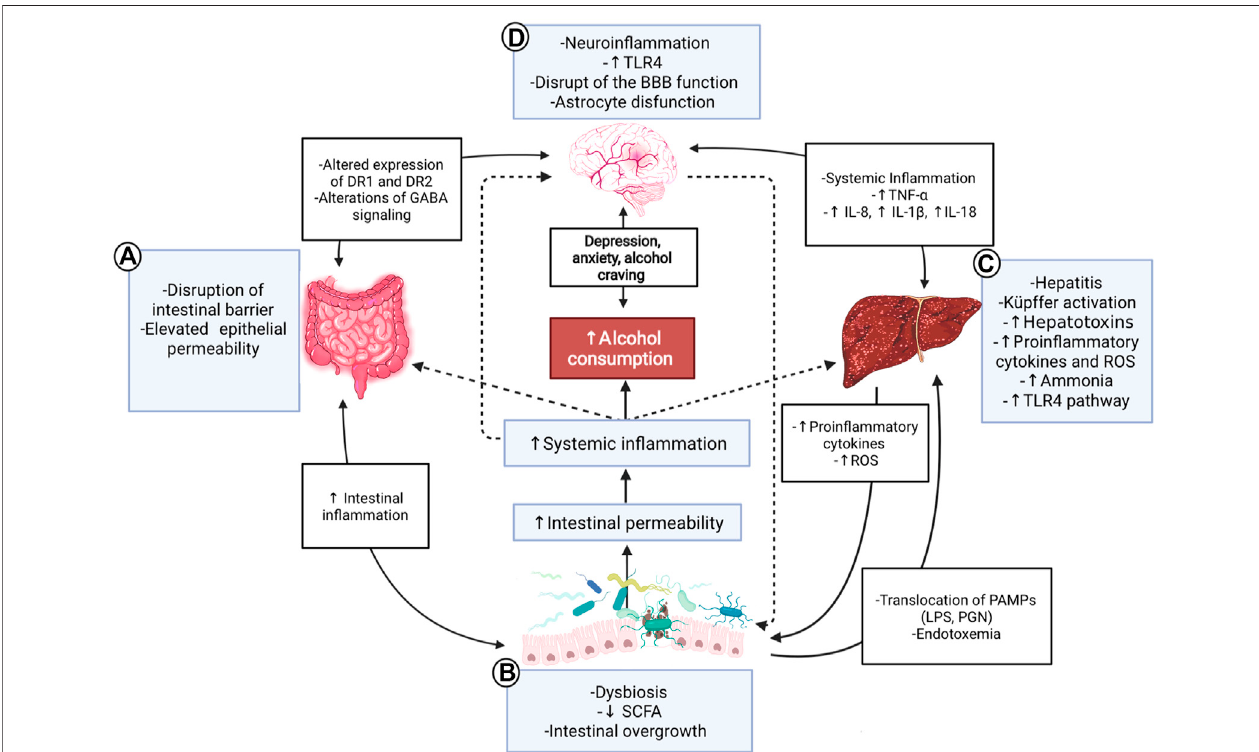
FIGURE1| Gut-microbiota-liver-brainaxisinALD.Interactiondiagramofthedifferentmechanismsparticipatinginthegut-microbiota-liver-brainaxisinvolvedinthe pathophysiology of ALD. (A) Alcohol consumption has adverse effects on the gut; it disrupts the gut barrier leading to high permeability and translocation of bacterial products. These effects create a proin fl ammatory environment which affects microbiota. (B) ALD has a speci fi c microbiota dysbiosis favoring an overgrowth of nonbene fi cial bacteria. The decrease of SCFA due to alcohol consumption in fl uences these alterations because SCFA is food for helpful bacteria. This context produces atranslocation ofdifferentsubstances called PAMPs, such as LPSor peptidoglycan, tothe liver and circulation, increasingendotoxemia. (C) The liver isavital organ in ethanol metabolization and suffers many changes in chronic consumption; activation of Küpffer cells and proin fl ammatory TLR4 pathway, causing hepatitis, increased reactive oxygen species, and cytokines, such as IL-18, IL-8, and IL-1 β . In advanced stages, the liver fails in its detox task, and organisms accumulate ammonia. (D) Alltheaforementionedin fl ammatoryprocessesleadtoasystemicin fl ammationthataffectsthebrain,contributingtoethanol-triggeredneuroin fl ammation. PAMPs and alcohol also produce disruption of the blood-brain barrier, astrocyte senescence, and more signi fi cant changes in the brain; alteration of the DR1 and 2, increased levels of anxiety, depression, and alcohol craving. Finally, the gut and the microbiota are in fl uenced by the brain and vice-versa through nerve and